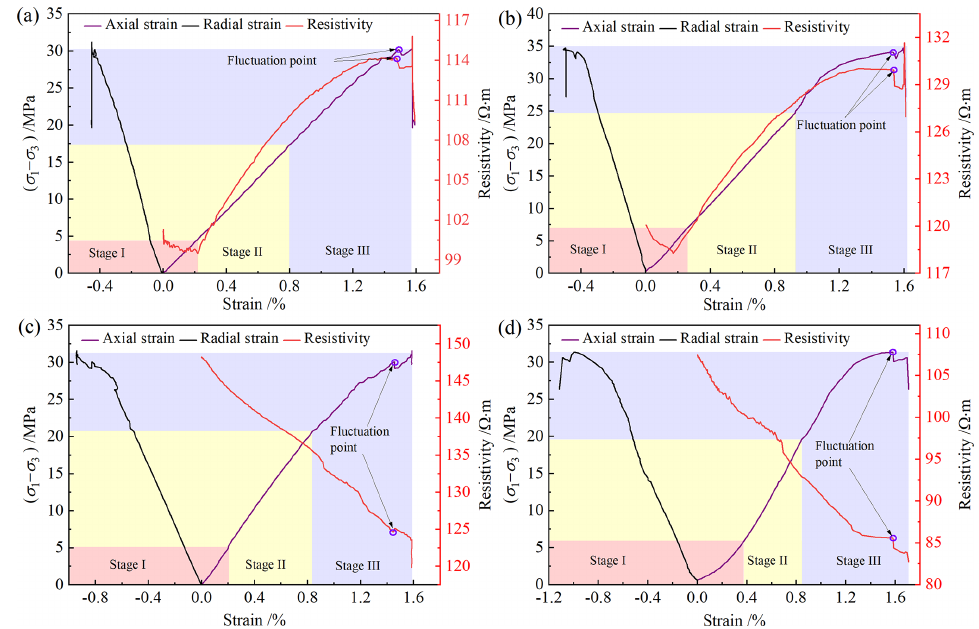
Figure 11. Stress–strain and resistivity curves. (a, b) Unfrozen coal specimen. (c, d) Freeze–thawed coal specimen.